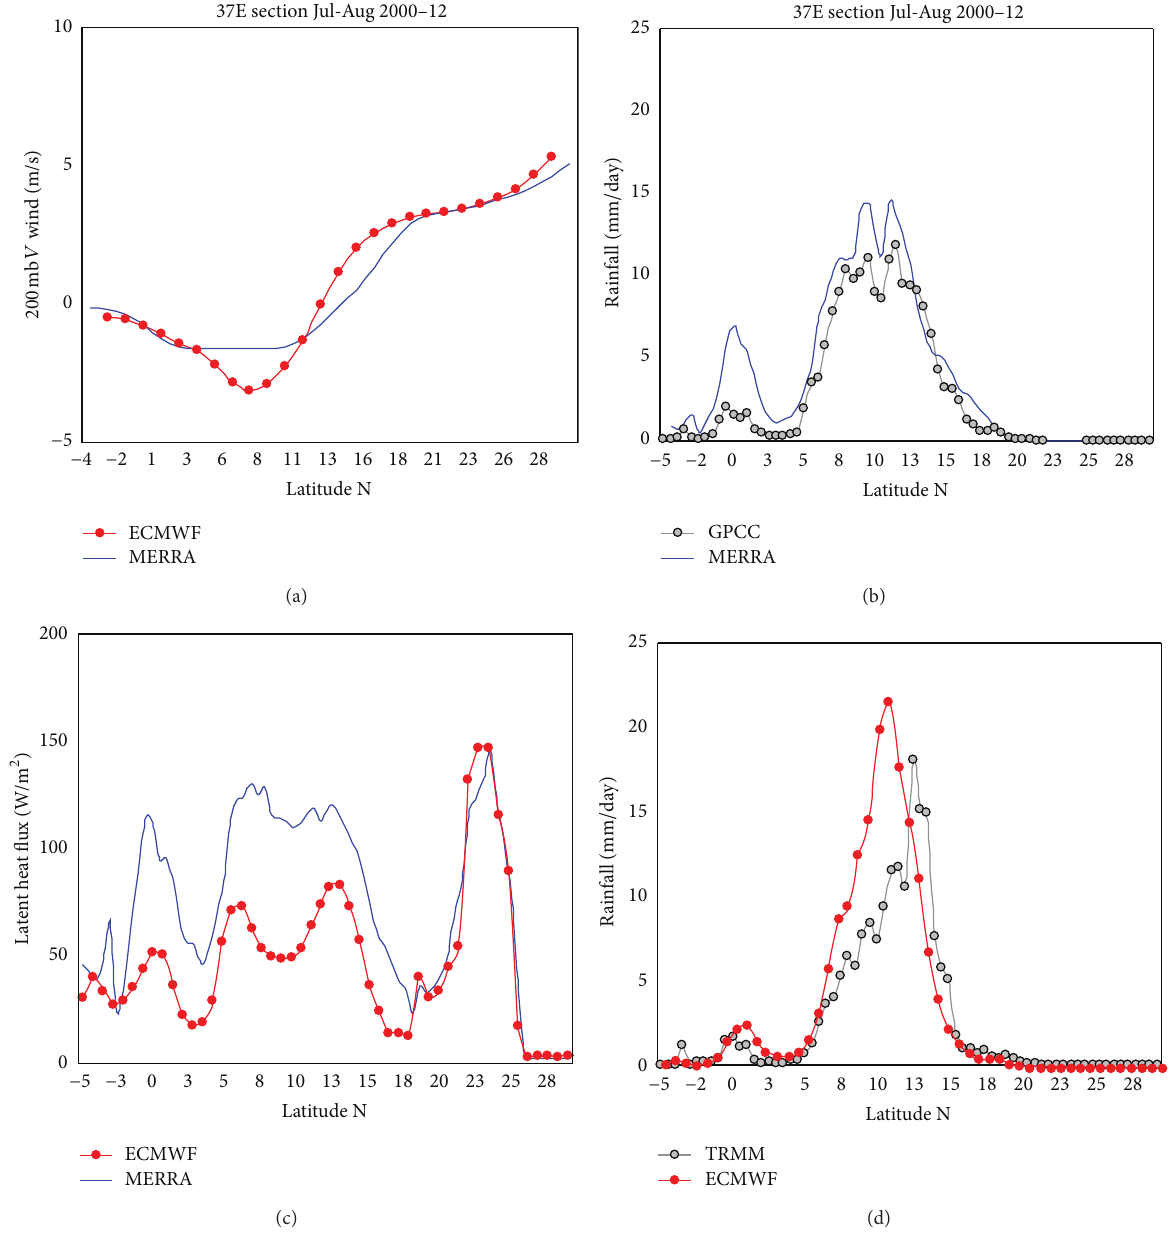
Figure 2: Mean July–August, 2000–2012, variables along N-S slice on 37 ∘ E for ECMWF and MERRA models: (a) 200 mb meridional wind, (b, d) rainfall from model and GPCC/TRMM observations, and (c) model latent heat flux.